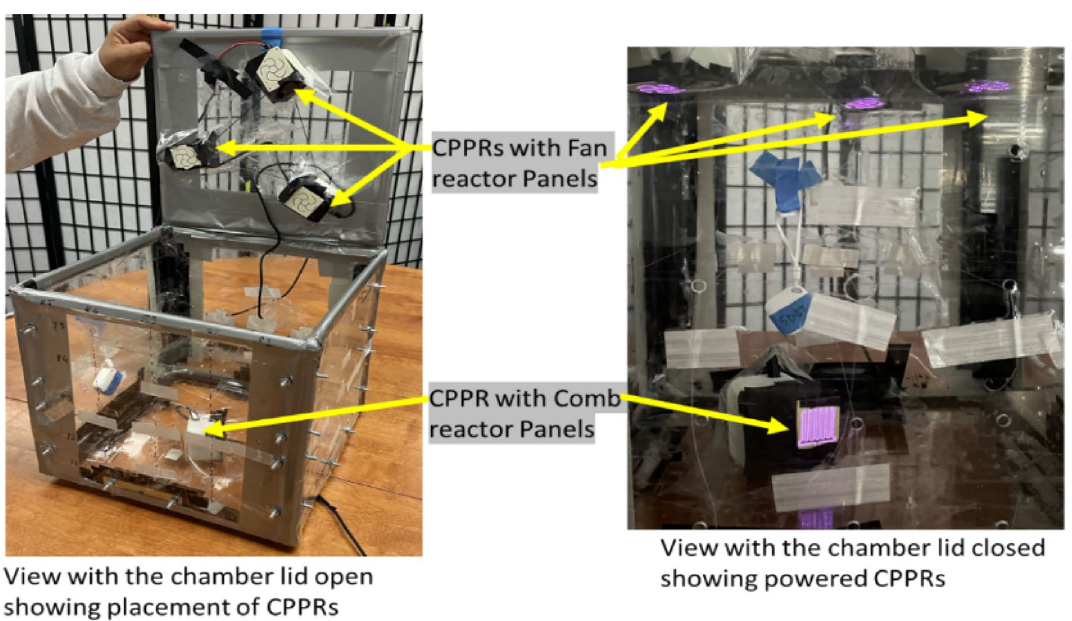
Figure 3. Integration of CPPRs and their placement inside the decontamination